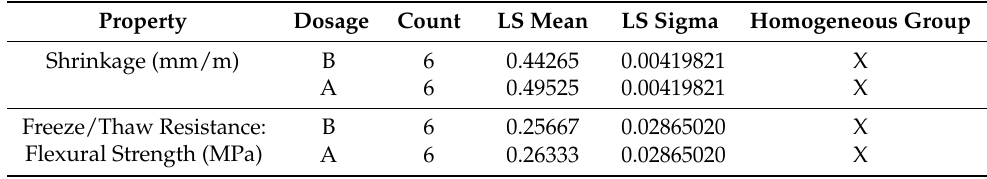
Table 16. Multi-range test for shrinkage and flexural strength considering the cement/aggregate ratio.